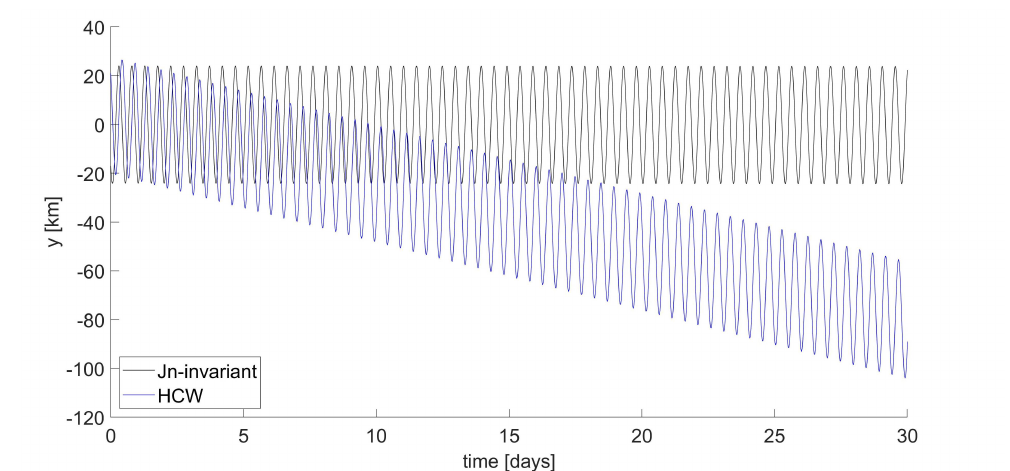
Figure 13. Lunar formation: time behavior of y component.